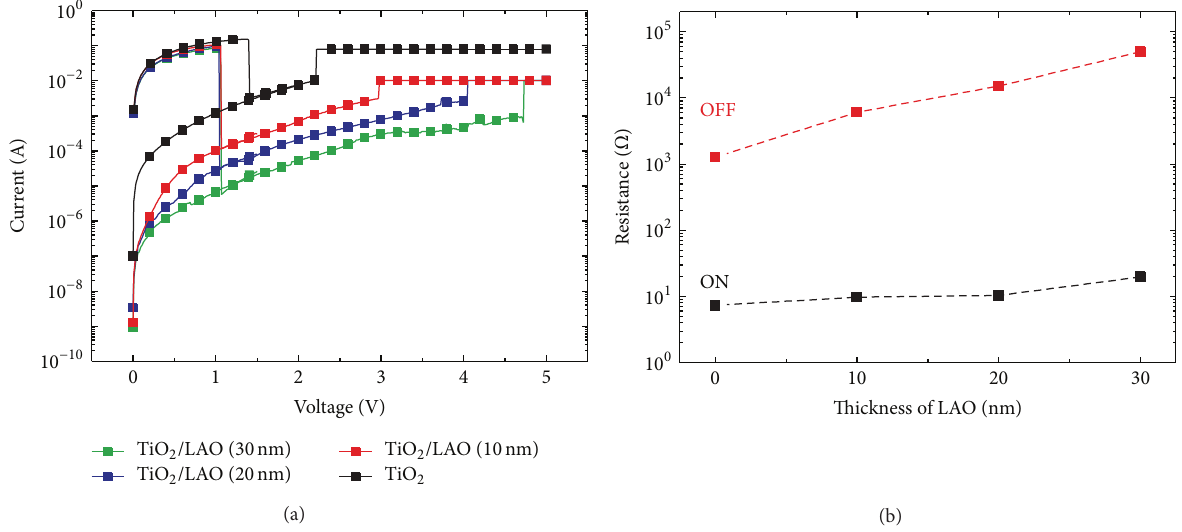
Figure 4: (a) Typical I-V curves of Pt/TiO 2 /LAO/Pt devices and (b) ON and OFF state resistance of Pt/TiO 2 /LAO/Pt devices as function of LAO